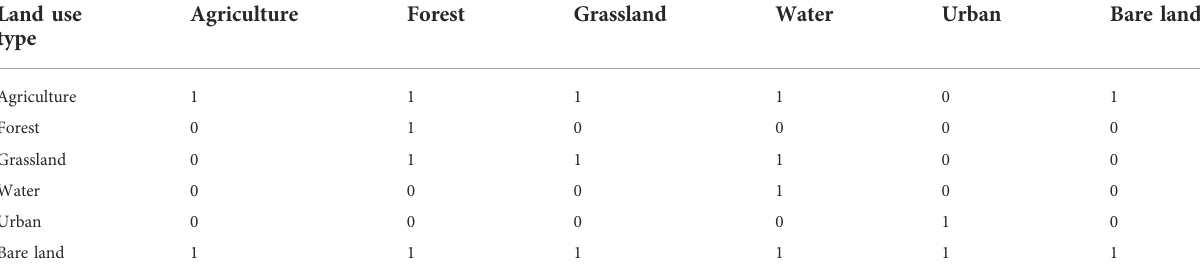
TABLE 3 Transfer matrix of land-use change under EPS.